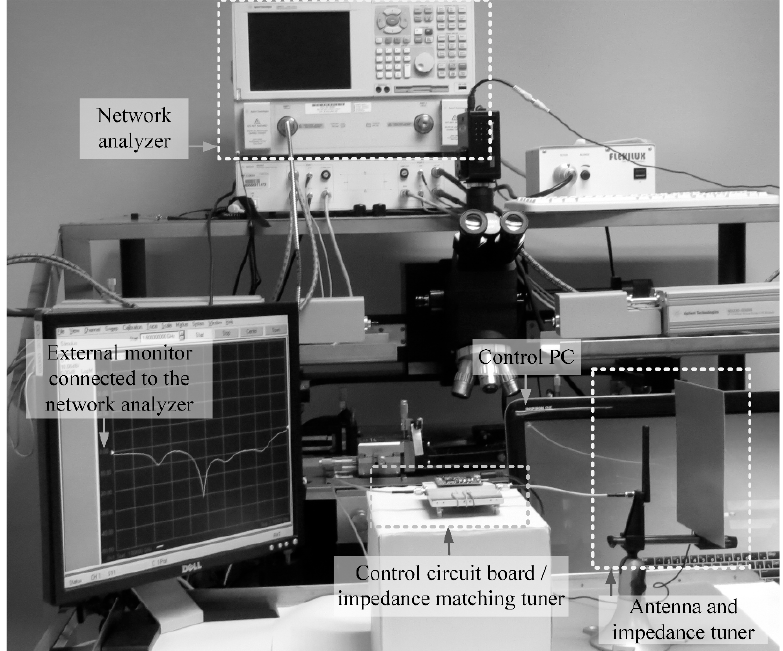
Figure 4. A photograph of the testing and validation system of the AIMS.